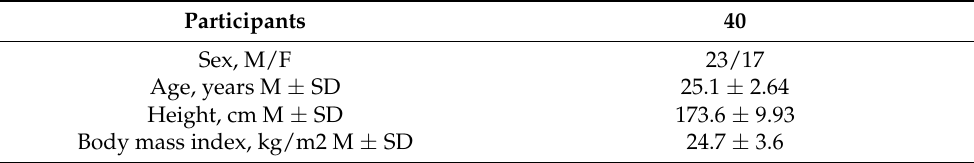
Table 1. Study population